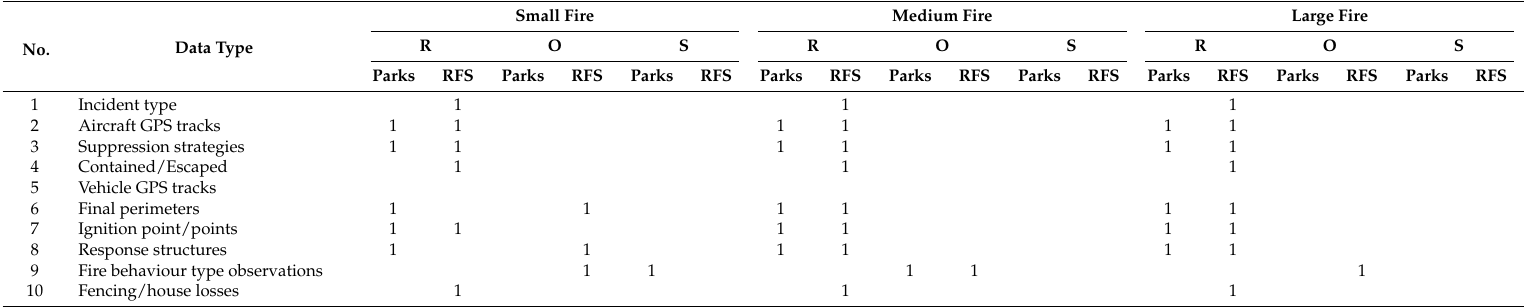
Table A4. New South